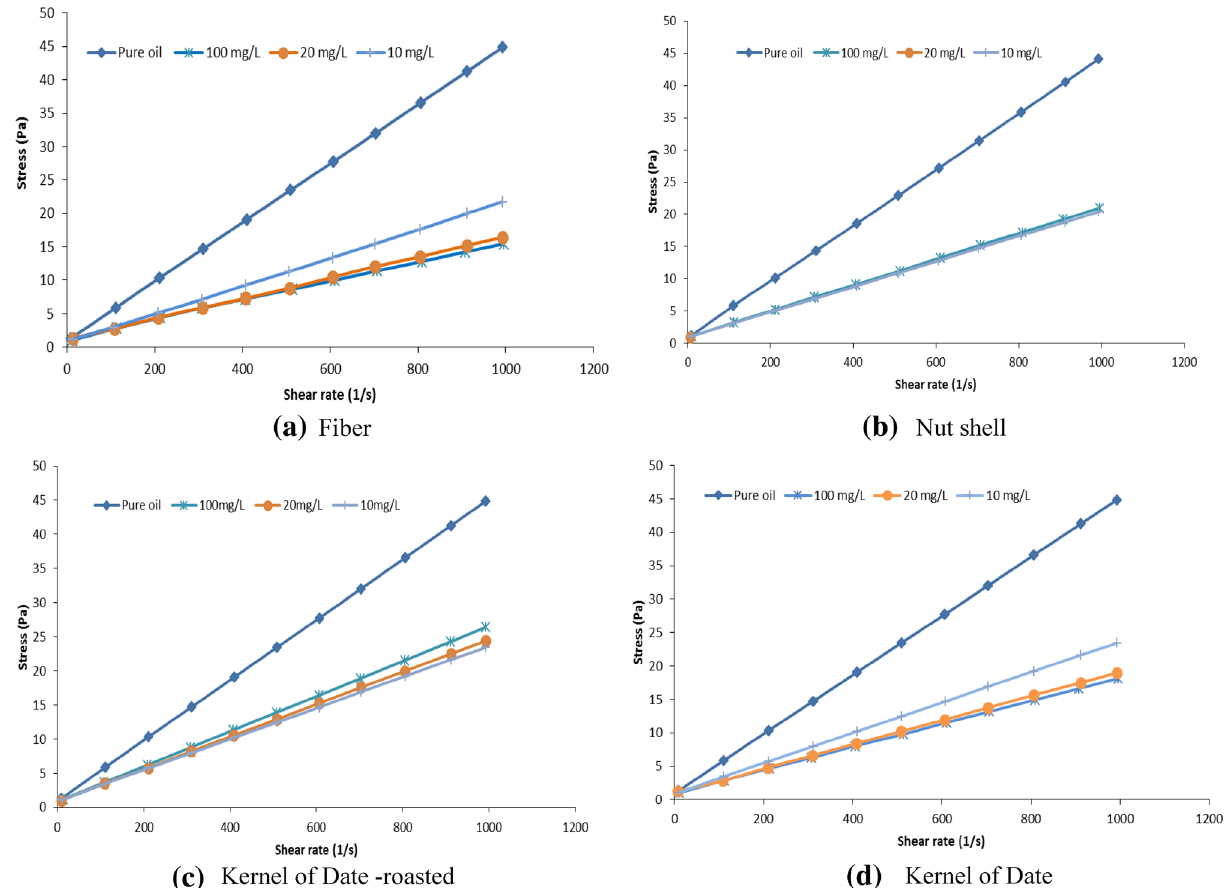
Fig. 7 Shear rate of light crude oil using bio materials (150